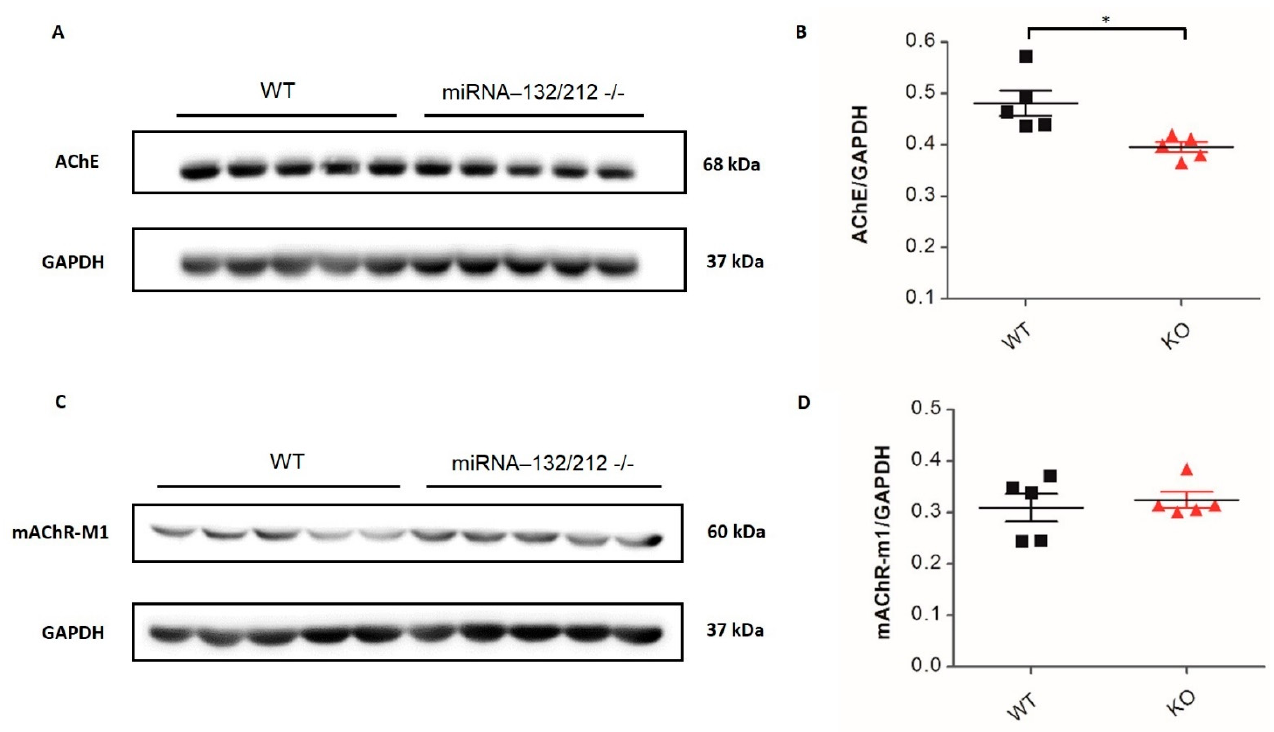
Figure 6. The hippocampal protein levels of acetylcholinesterase but not M1-mAChR are altered in miRNA-132/212 − / − mice. Western blot from hippocampal tissue was used to assess the levels of expression of the proteins AChE and mAChR-M1. ( A ) Demonstrative blots and ( B ) relative expression of AChE and GAPDH, showing a significant decrease in AChE in miRNA-132/212 − / − mice, in comparison to WT mice (* = p < 0.05). ( C ) Illustrative blots and ( D ) relative protein expression of mAChR-M1 and GAPDH, showing no differences for mAChR-M1 in miRNA-132/212 − / − tissue compared to WT ( p > 0.05; t -test). Results are shown as fold change normalized to GAPDH protein levels. Data are shown as mean ± SD, n = 5/group. kDa = kilodalton.